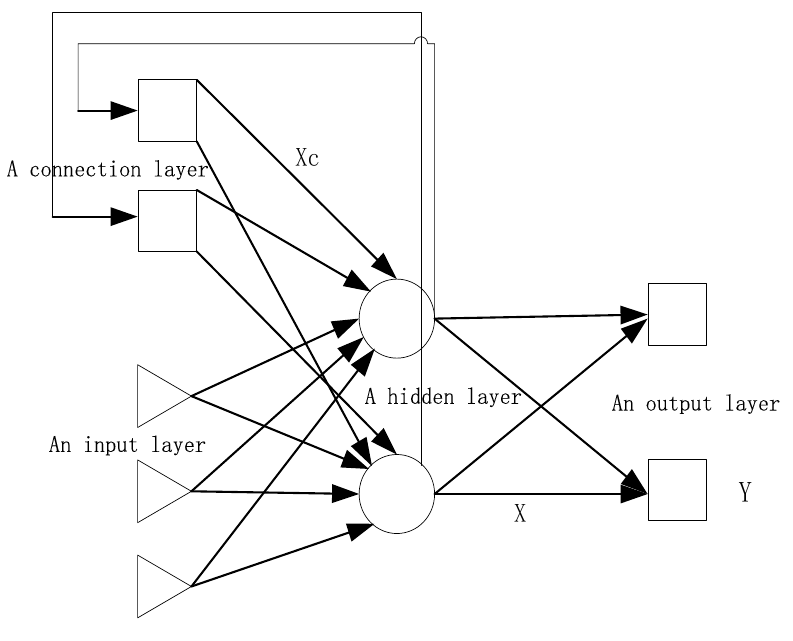
Figure 3. Elman neural network structure.